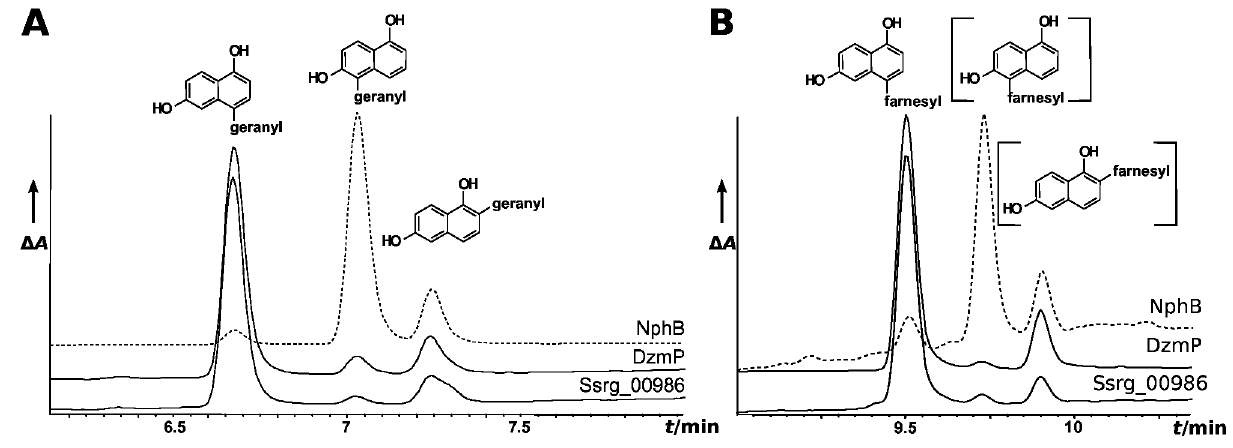
Figure 7. Geranylation (A) or farnesylation (B) of 1,6-DHN under catalysis of NphB, DzmP and Ssrg_00986. Reaction products were analyzed by HPLC with UV detection at 286 nm. Absorbance was scaled differently for each enzyme in order to improve visibility of the product